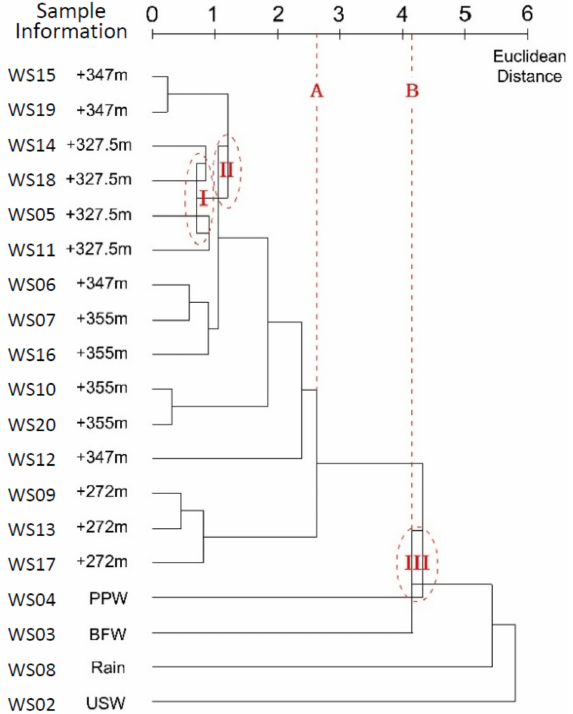
Figure 10. Dendrogram of data through the centroid